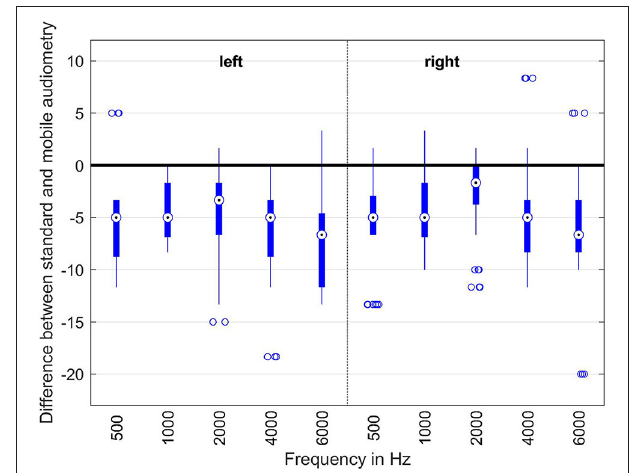
In Figure 12 , the results of the audiogram measurements